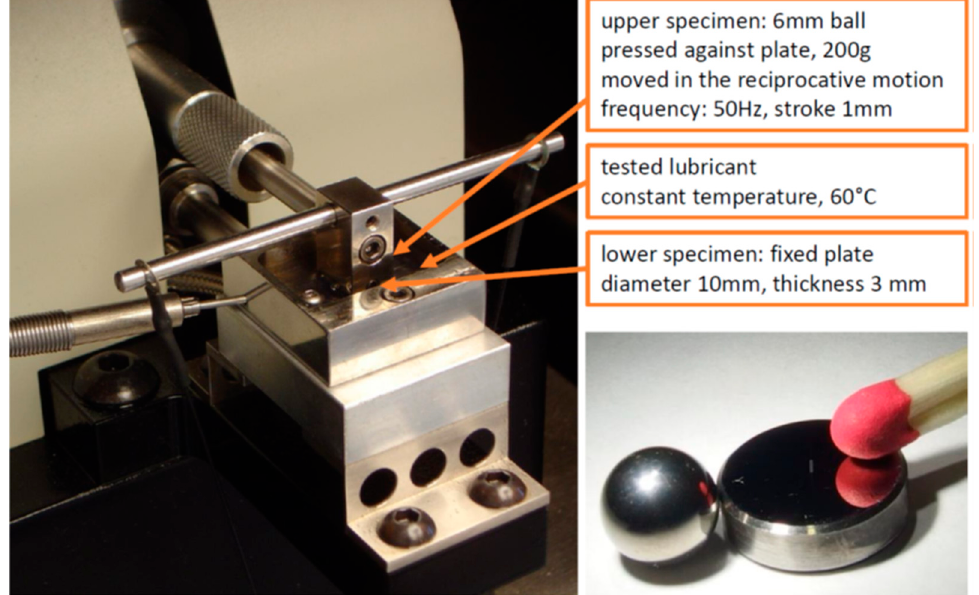
Figure 1. High Frequency Reciprocating Rig (HFRR) tribometer design, test conditions and friction track in the middle of the tested plate as pointed to by the tip of a match. Table 1. Parameters of PAO6 oil used as a reference and base oil to produce the tested lubricants. Property